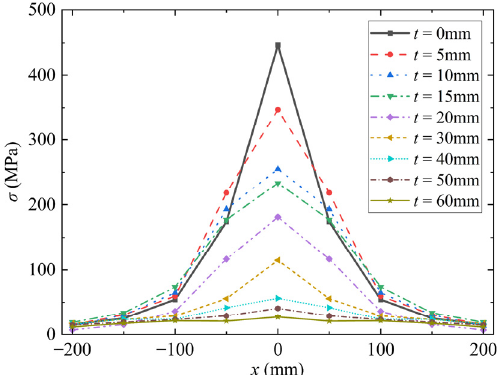
Figure 15. Stress distribution on the front side of RC walls with different coating thicknesses.